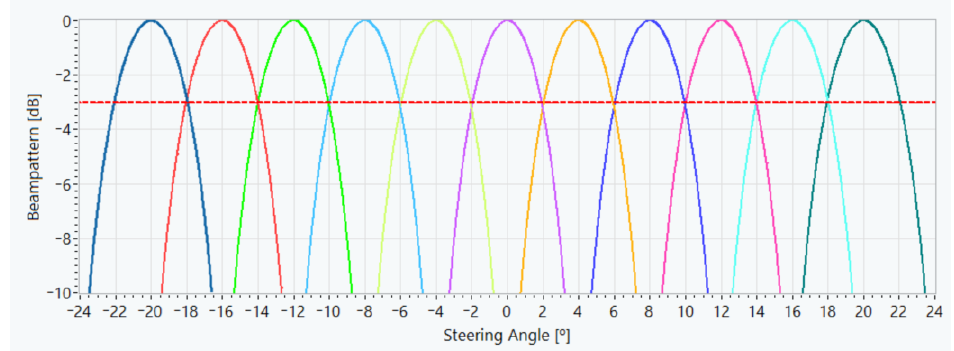
Figure 6. Beampatterns of the 11 defined beams.